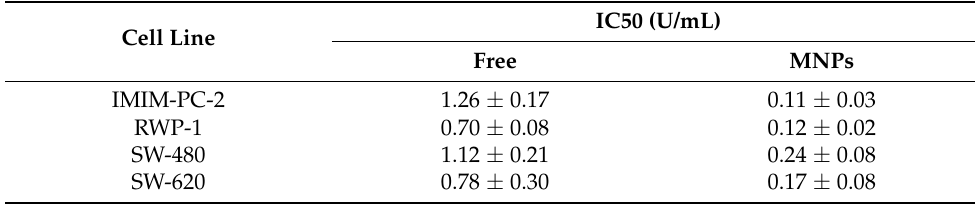
Figure 3. Anti-proliferative effect of CLytA-DAAO, free and bound to MNPs, on pancreatic and colorectal carcinoma cell lines. Cells were treated with CLytA-DAAO, free or immobilized, in a concentration range between 0.025-2 U/mL and 1 mM D-Ala for 24 h and cell proliferation was determined by MTT assay. Graph shows the proliferation percentage ± SD respect to control untreated versus the logarithm of the concentration ( n ≥ 6). Table 2. IC50 value of CLytA-DAAO, free and bound to MNPs, on pancreatic and colorectal carci- noma cell lines. Cells were treated with a concentration range between 0.025-2 U/mL CLytA-DAAO and 1 mM D-Ala for 24 h.